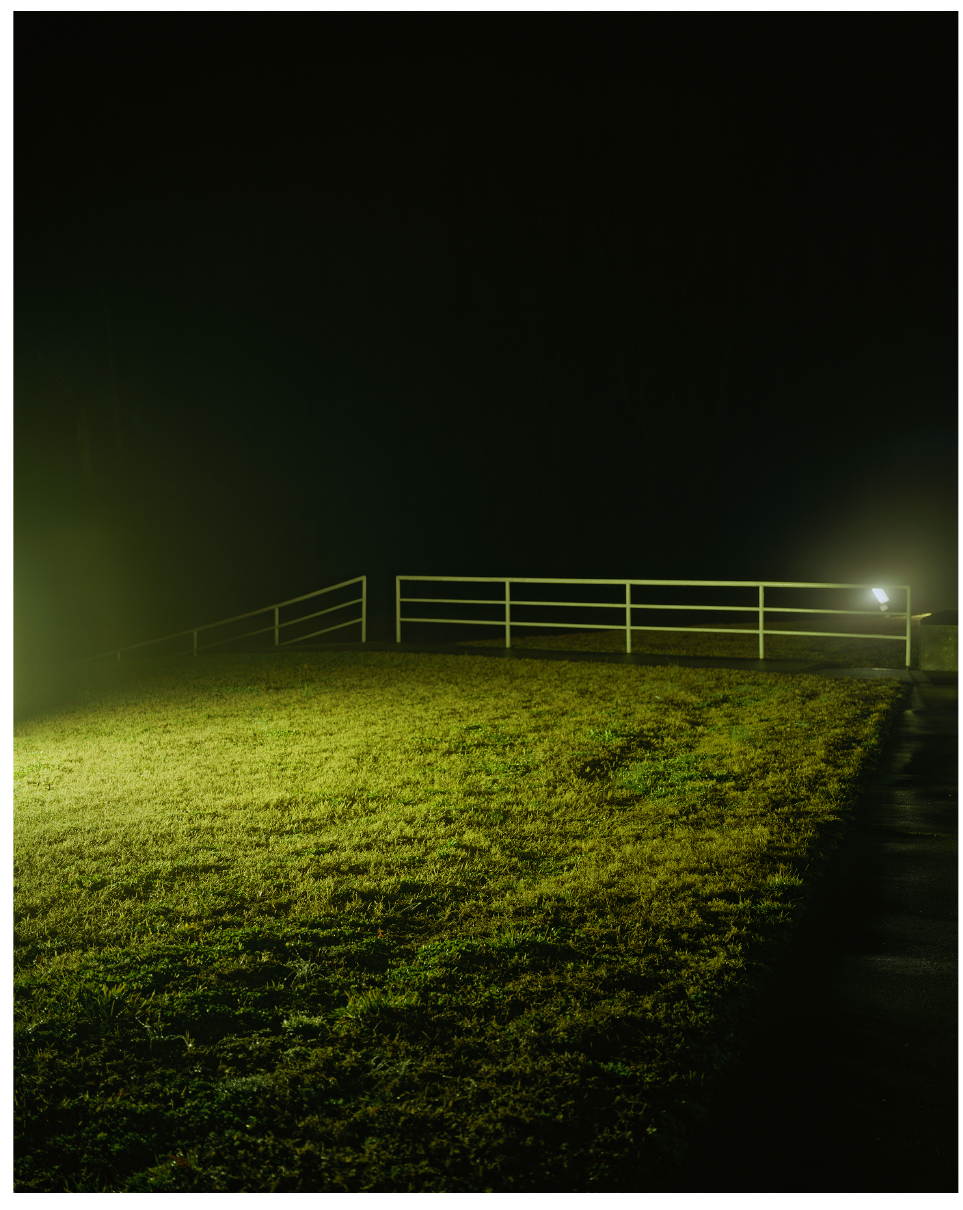
Regina Mamou, Richard Meier's Vision for Athene, Night #2 , 2012. Digital C-Print, 40 x 32 in. (photo: courtesy of the